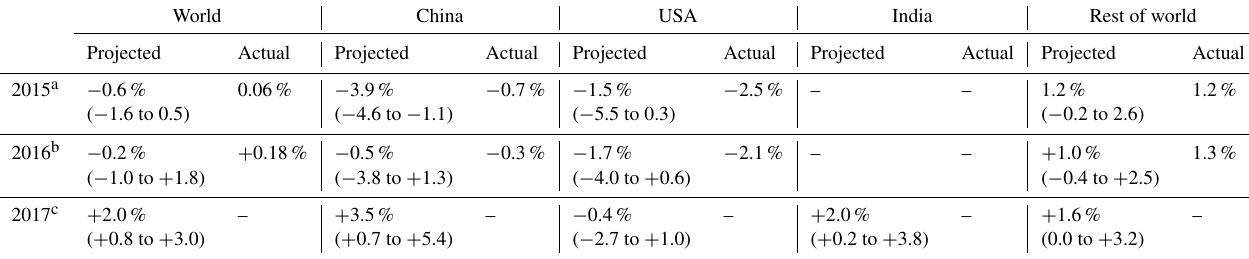
Table 7. Comparison of the projection with realised emissions from fossil fuels and industry ( E FF ). The “Actual” values are first estimate available using actual data, and the “Projected” values refer to the estimate made before the end of the year for each publication. Projections based on a different method from that described here during 2008–2014 are available in Le Quéré et al. (2016). All values are adjusted for leap years.